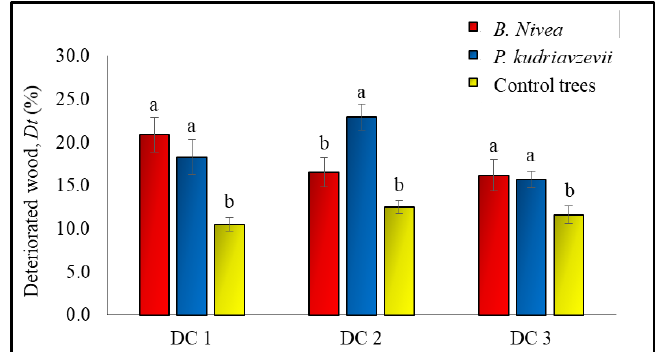
Figure 8. The affected area of Dt % in the sapwood of A. malaccensis tree at different diameter classes. Note: DC1 = small-diameter class, DC2 = medium-diameter class, DC3 = large-diameter class. The error bar represents the mean standard error (n = 27); distinct letters imply significant distinctions between inoculation treatments following Duncan’s multiple comparison test ( p < 0.05).